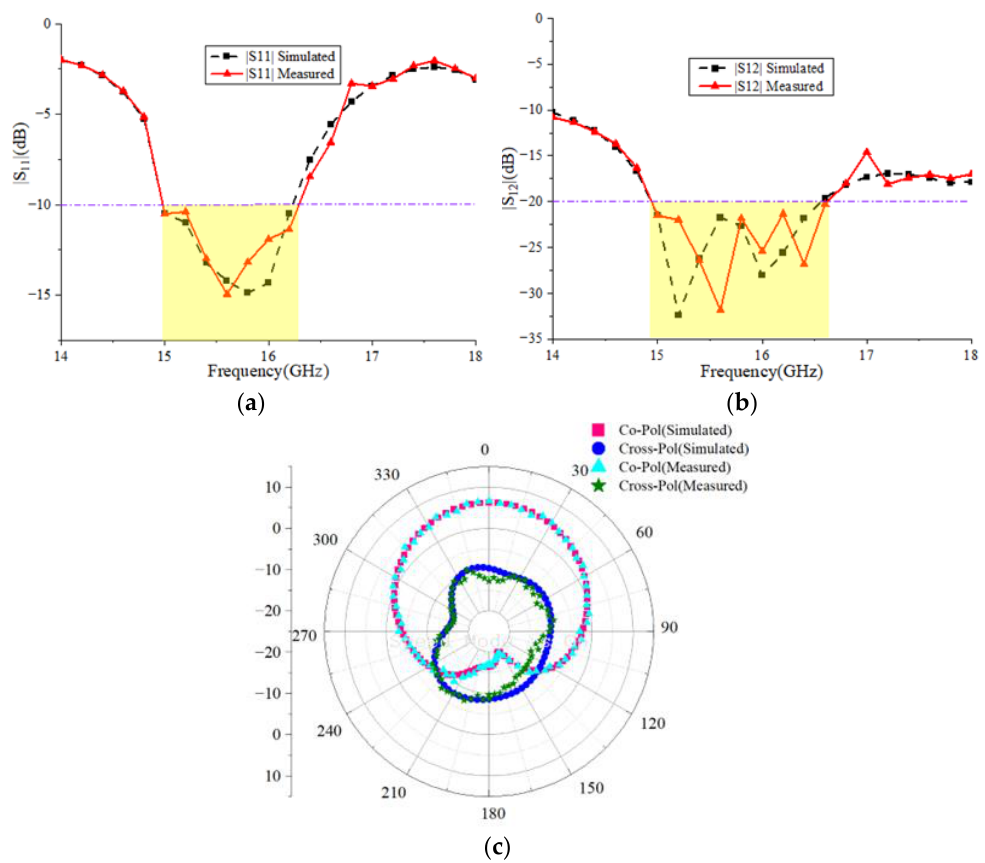
Figure 4. Simulation and measurement results of the dipole antenna: ( a ) |S11|; ( b ) |S12|; and ( c ) co/cross-pol radiation patterns.